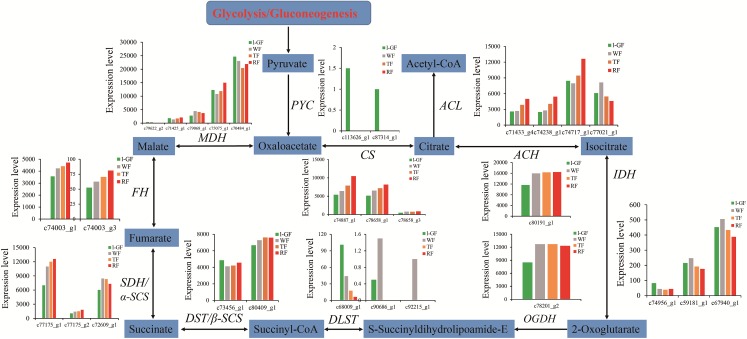
The expression pattern of genes involved in citrate cycle.Enzyme names, unigene ids and expression patterns are indicated on each step. The y-axis represents average read_count value of each library. Study sites: PYC, acetyl-CoA C-acetyltransferase; MDH, malate dehydrogenase; FH, fumarate hydratase; SDH/α-SCS, succinate dehydrogenase/succinyl-CoA synthetase alpha subunit; DST/β-SCS, dihydrolipoamide succinyltransferase/succinyl-CoA synthetase beta subunit; DLST, dihydrolipoamide succinyltransferase; OGDH, 2-oxoglutarate dehydrogenase E1 component; IDH, isocitrate dehydrogenase; ACH, aconitate hydratase; CS, citrate synthase; ACL, ATP citrate (pro-S)-lyase.